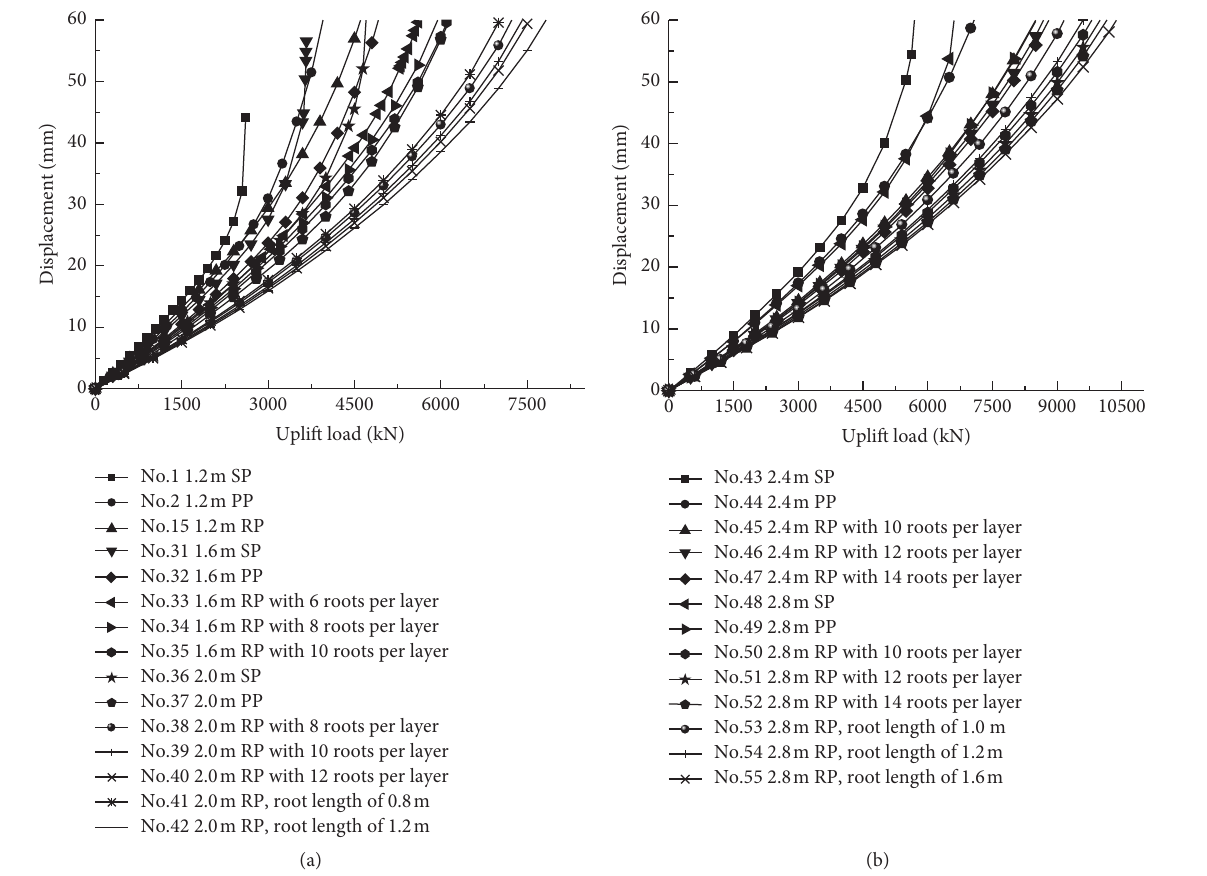
Figure 13: : Uplift load displacement of piles with different diameter. (a) Pile diameter of 1.2, 1.6, and 2.0m. (b) Pile diameter of 2.4 and